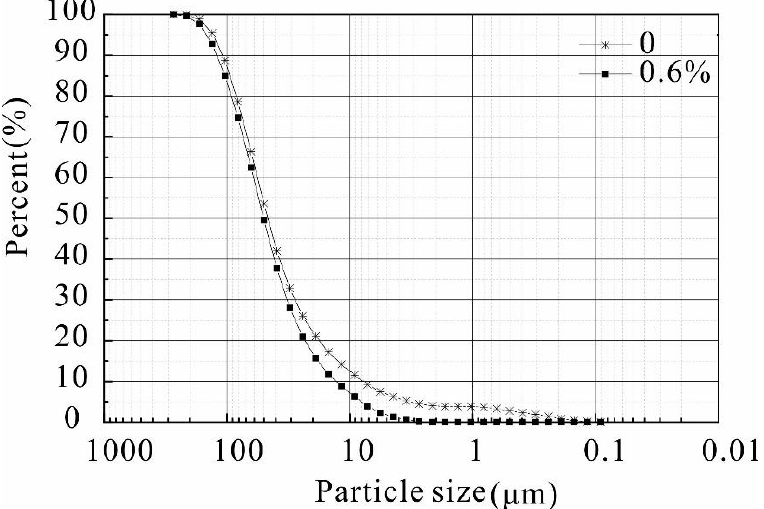
Figure 16. Particle size grading curve of loess with different stabilizer concentrations.